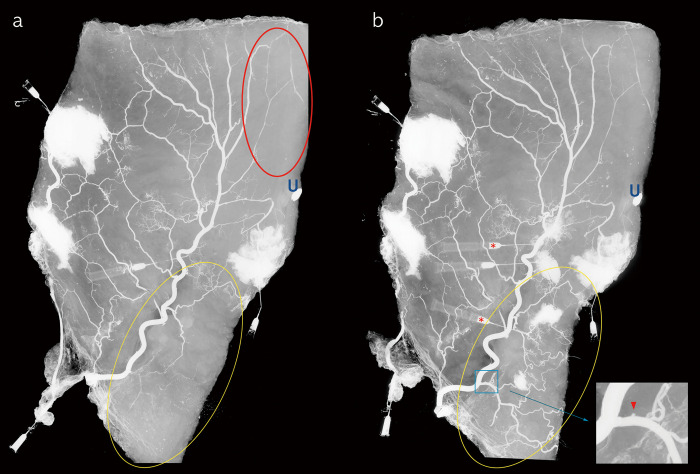
Venograms of the hemi-abdominal specimen.(a) Barium was injected through the caudal end of the superficial inferior epigastric vein and the lateral venous stump. Veins in the supraumbilical midline area were well visualized from an early period (red ellipse). (b) Advanced cannulation and injection into the medial branch of the superficial inferior epigastric vein visualized the veins in the infraumbilical midline area (red asterisks). Note the change in the infraumbilical midline area (yellow ellipse). The magnified image shows a diverticulum-like projection indicating the valve structures (red arrowhead).